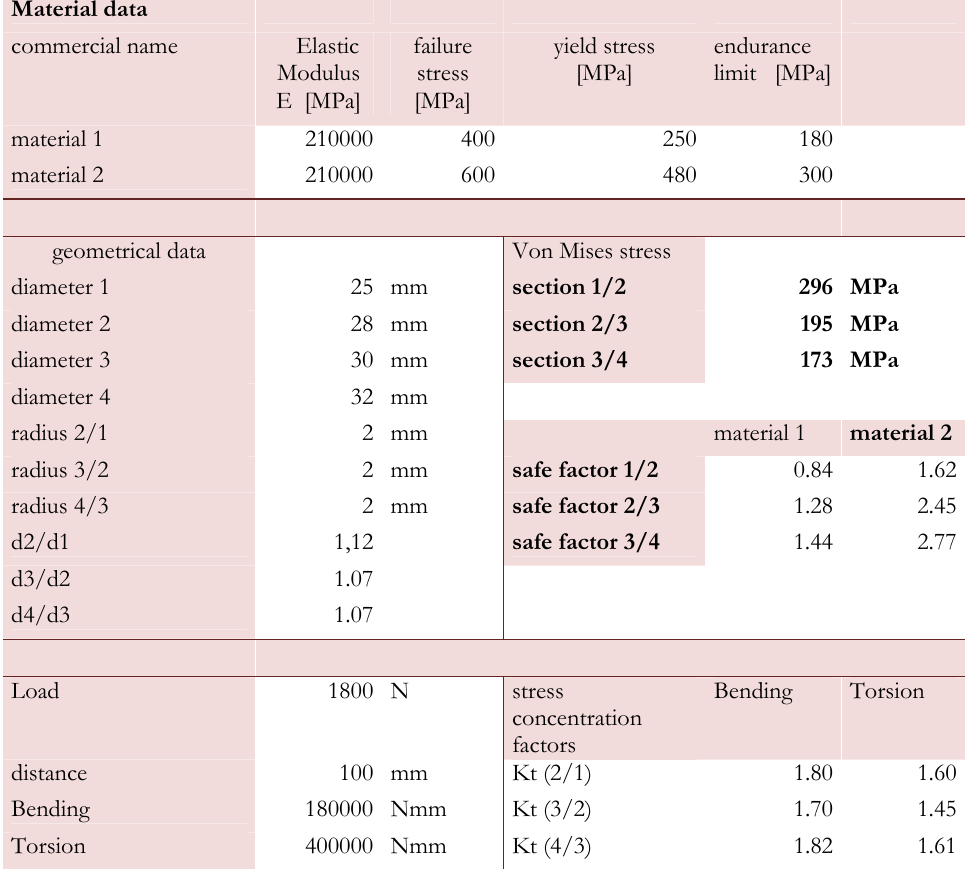
Table 1: Example of the work sheet implemented for